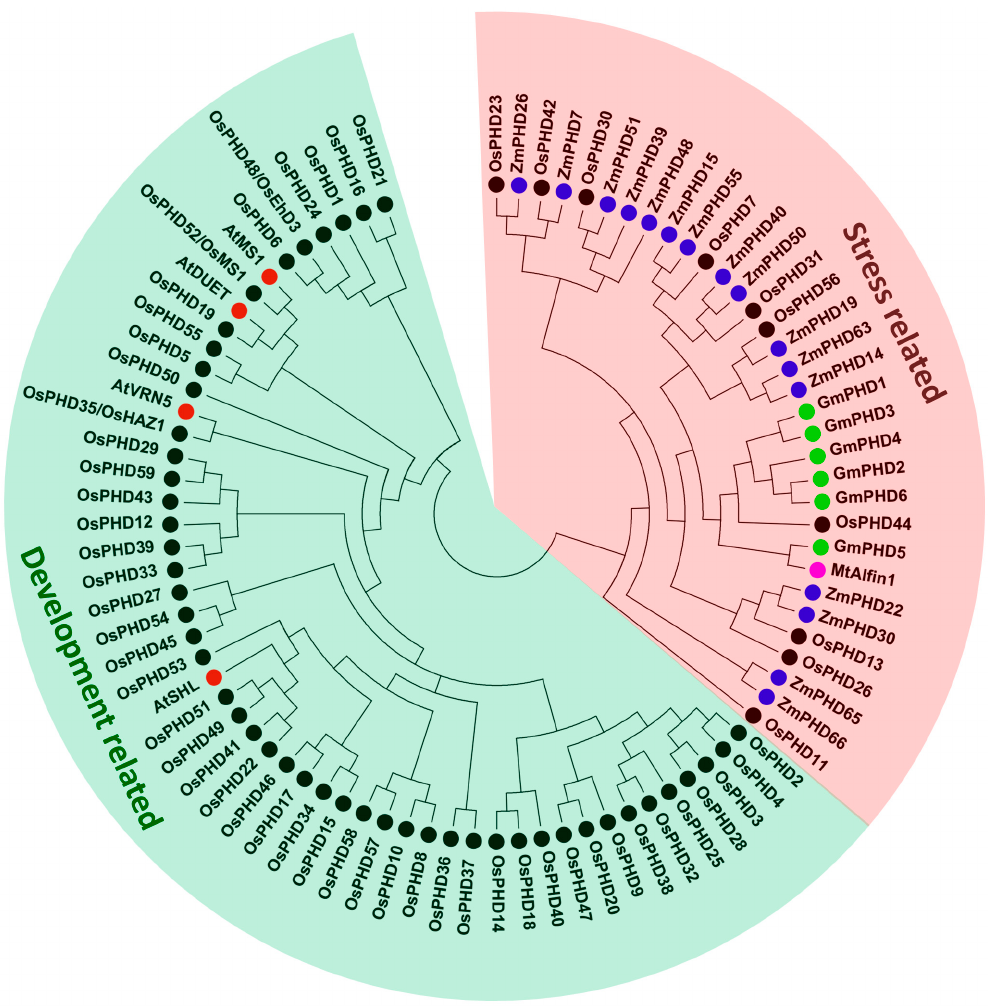
Figure 3. Phylogenetic tree analyses of all OsPHDs proteins and PHDs from other species. The phylogenetic tree was constructed based on the full-length amino acid sequences by using MEGA5.0 software with the Neighbor–Joining method. The red shade marks the stress related cluster that includes 10 OsPHDs as well as 6 GmPHDs and 16 ZmPHDs which are characterized to participate in stress responses. The green shade marks other OsPHDs and some PHD proteins from Arabidopsis and alfalfa that are linked to plant growth and development regulation.